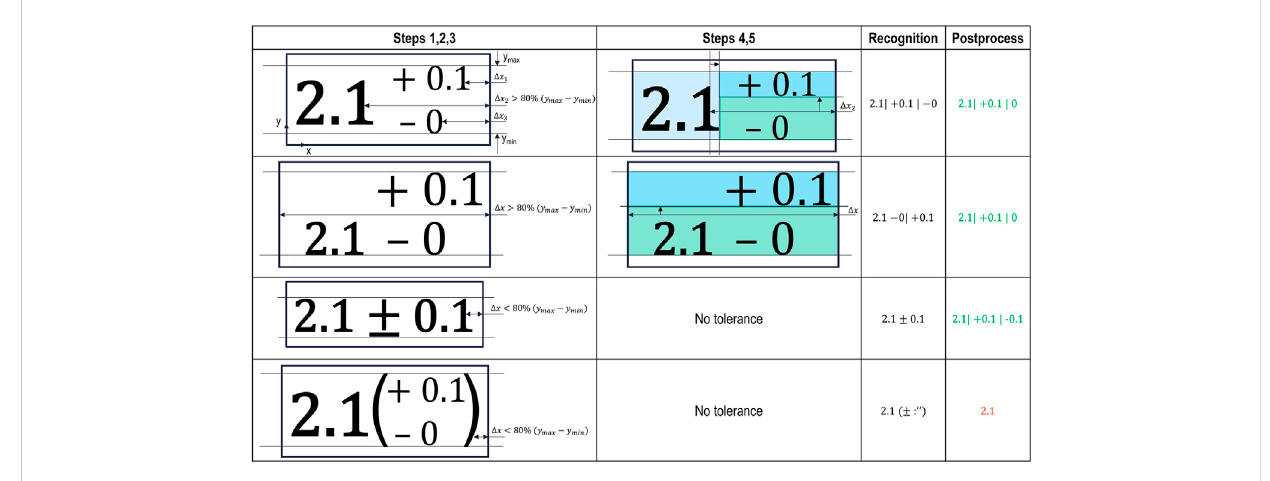
FIGURE 10 Tolerance check algorithm table for different tolerance layout. The top most example details the process in higher detail. The algorithm in combination with recognition and post-processing return positive results for three out of the four examples presented, while the forth example is an “ algorithm killer.